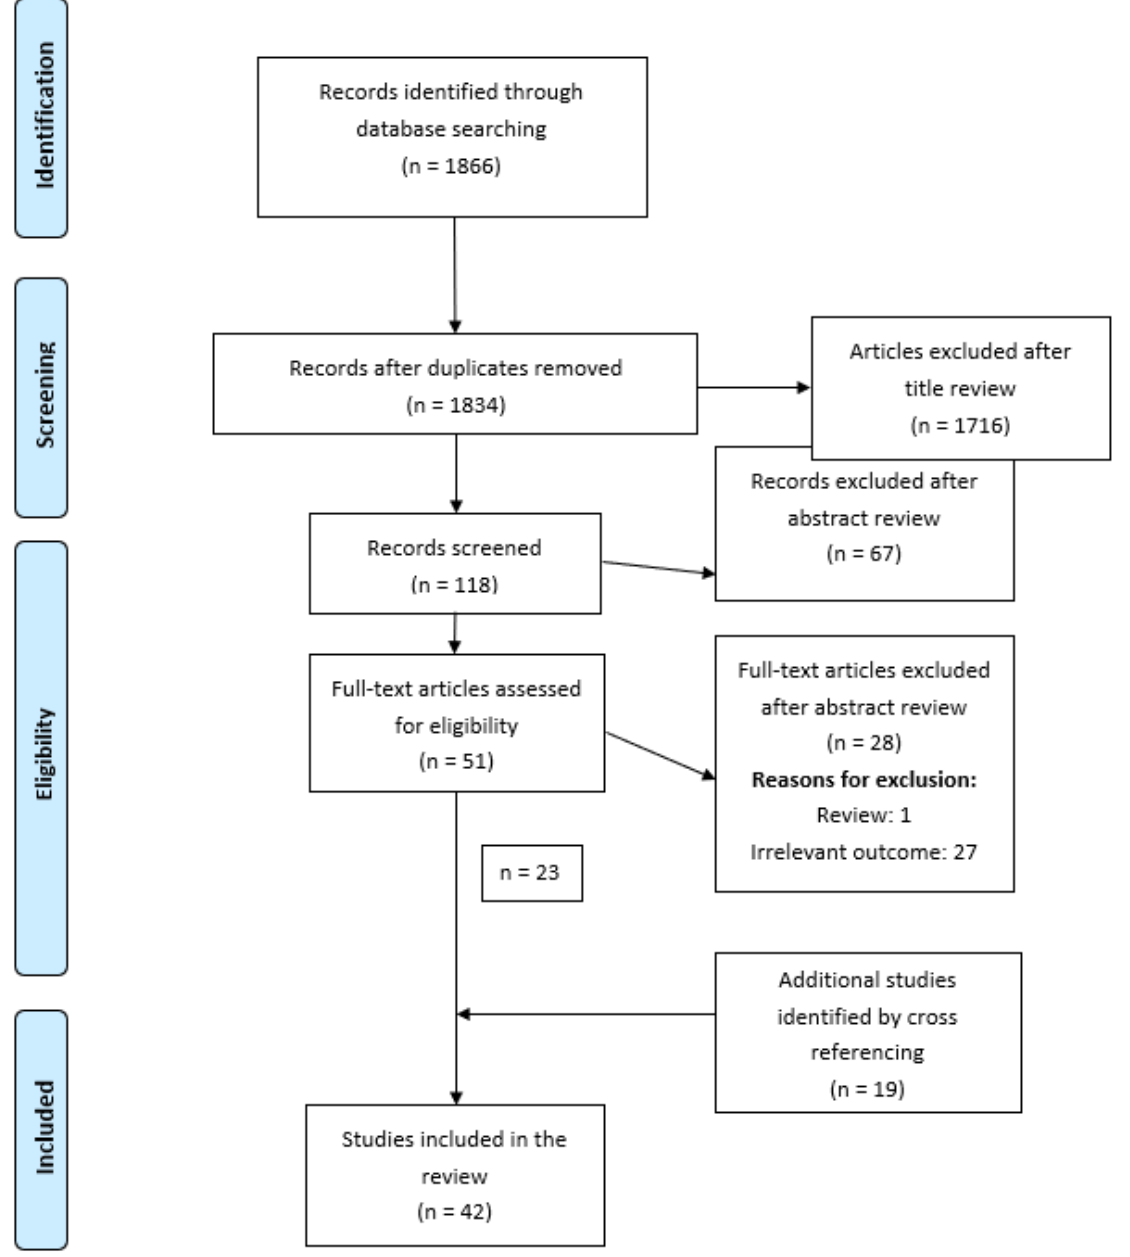
Figure A1. PRISMA. Figure A1.